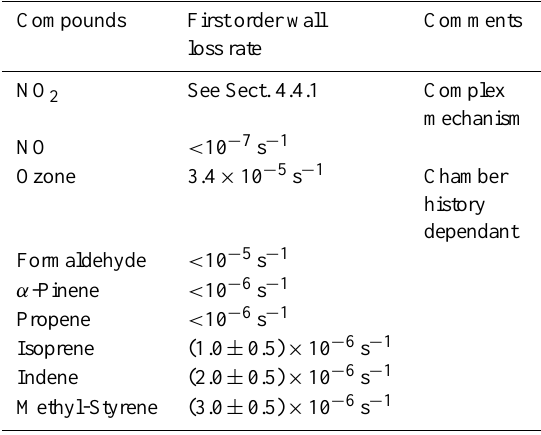
Table 5. Pseudo-first order rates for loss processes in